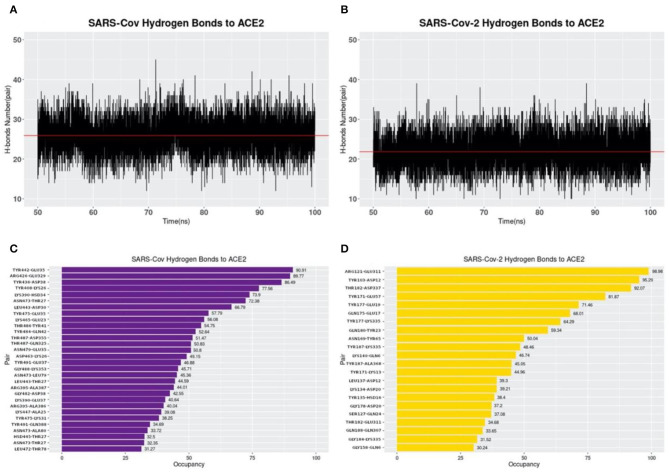
Hydrogen bonds at interfaces of S protein RBDs and ACE2 RBD with their occupancies. (A) Number of hydrogen bonds between SARS-CoV S protein RBD and ACE2 binding domain during the MD simulation. The average number of hydrogen bonds is shown as a red line, with the value of 25.90 pairs. (B) Number of hydrogen bonds between SARS-CoV-2 S protein RBD and ACE2 binding domain in the MD simulation. The average number of hydrogen bonds is 21.85, shown as the red line; (C) Occupancies of 30 pairs of hydrogen bonds (with a cutoff value of 30%) forming at the interface of SARS-CoV S protein RBD and ACE2 protein binding domain. (D) Occupancies of 22 pairs of hydrogen bonds forming at the interface of SARS-CoV-2 S protein RBD and ACE2 protein binding domain. For each hydrogen bond pair, the residue on the left is from S protein RBD while that on the right is from ACE2.